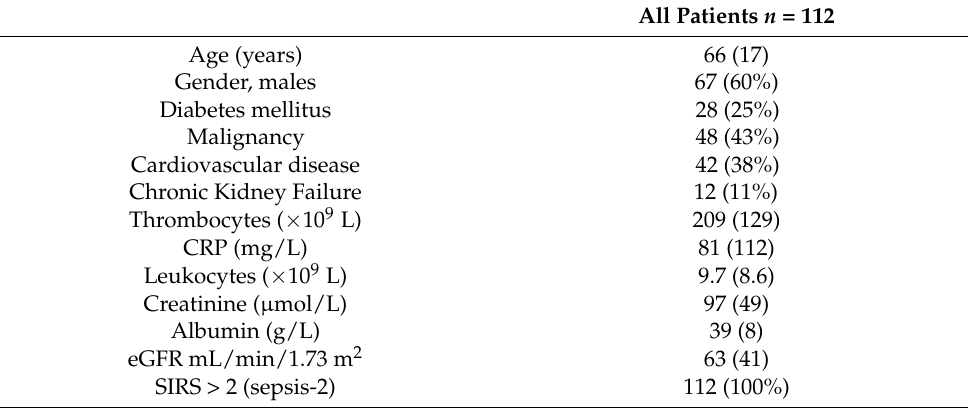
Table 1. Baseline study population